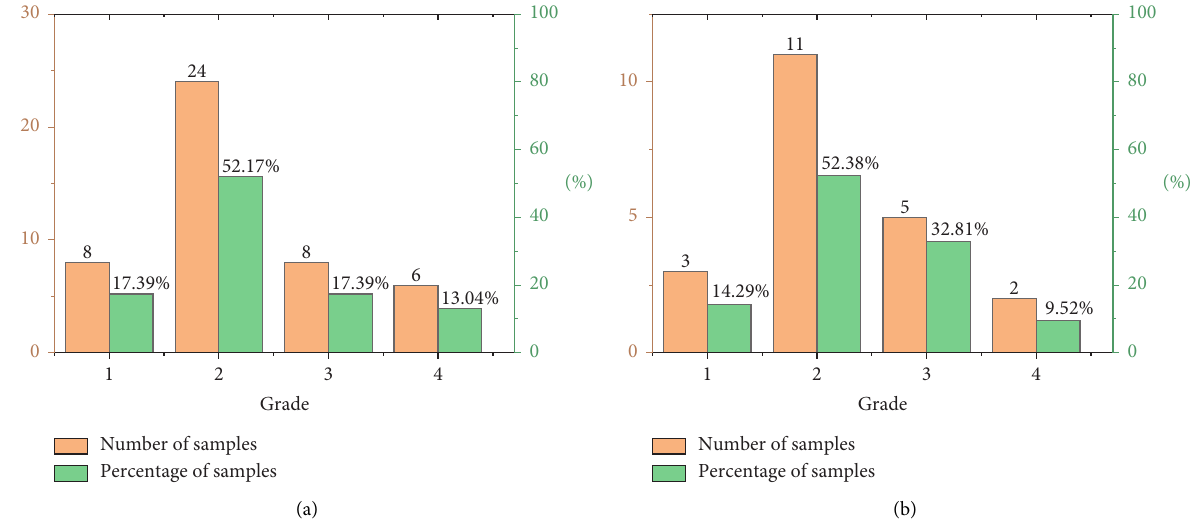
Figure 5: Sample data distribution of training set and test set. (a) Distribution of training sample data. (b) Distribution of test sample